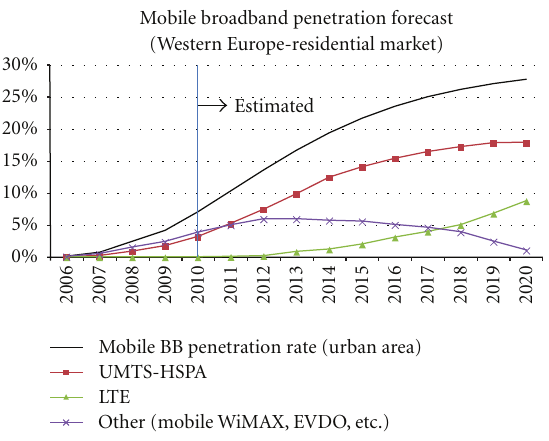
Figure 3: Mobile BB penetration forecasts (residential